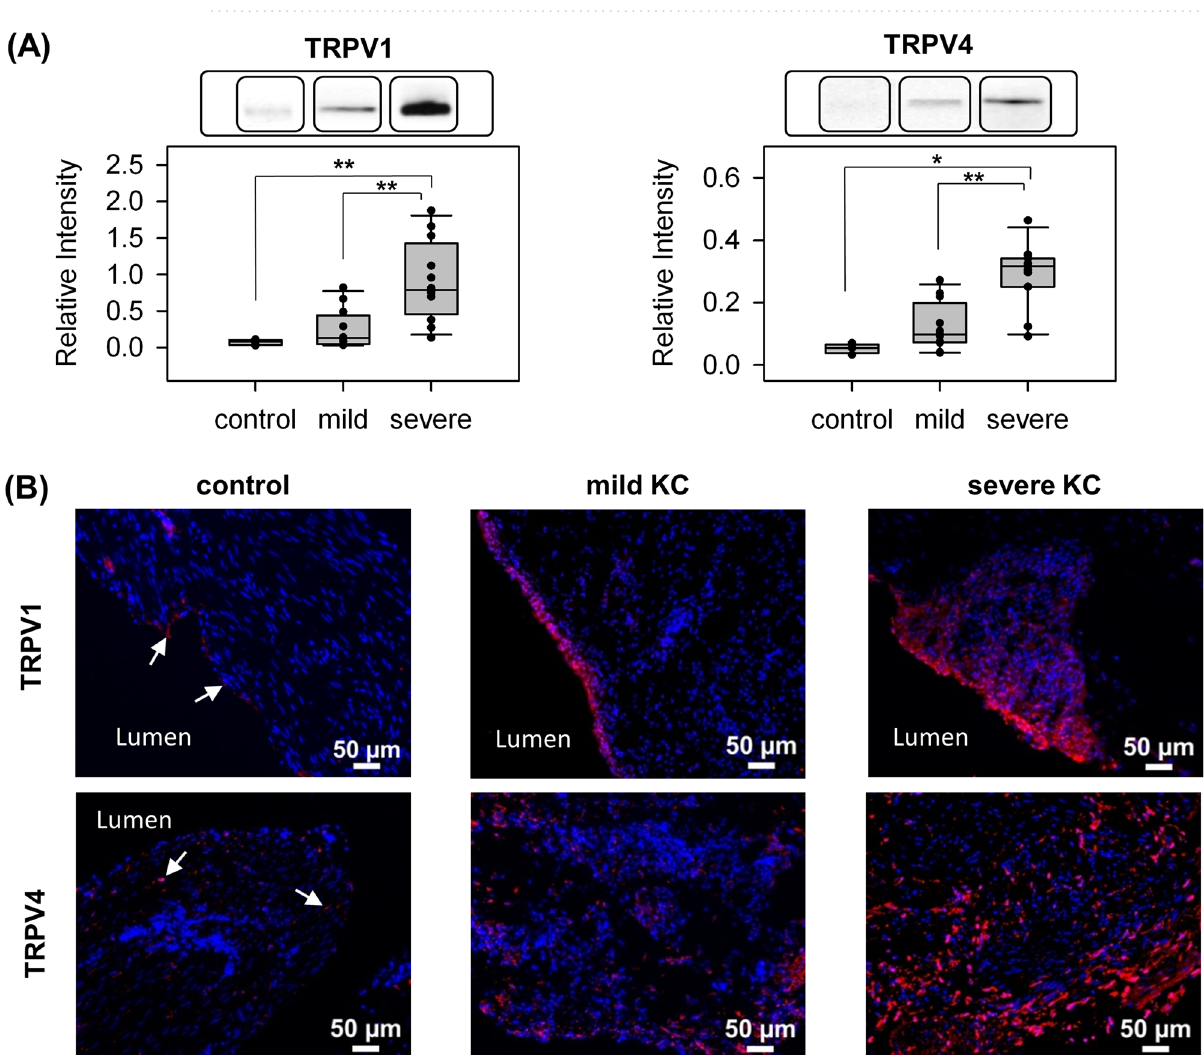
Figure 2. Higher expression of TRPV1 and TRPV4 in KC bladders than in control bladders. ( A ) Representative results of Western blot analysis (from different experiments) and scatter plot of the quantification of TRPV1 and TRPV4 to GAPDH in control, mild KC, and severe KC bladder specimens. The bar graph was quantified using ImageMaster TotalLab. * P < 0.05 and ** P < 0.01. Images for GAPDH and from all samples are available in Supplementary Fig. S1. ( B ) Representative results of immunofluorescence staining with TRPV1 and TRPV4 in control (arrows), mild KC, and severe KC bladder specimens. Stronger TRPV1 and TRPV4 fluorescence (red) was detected in severe KC specimens than in mild KC specimens. Nuclei were labeled with DAPI